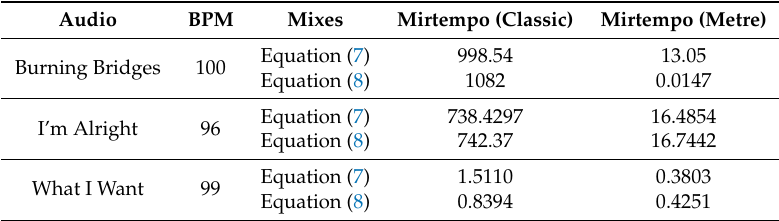
Table 1. Summary of tempo estimation accuracy results. Shown is the mean squared error (MSE) in each set of 500